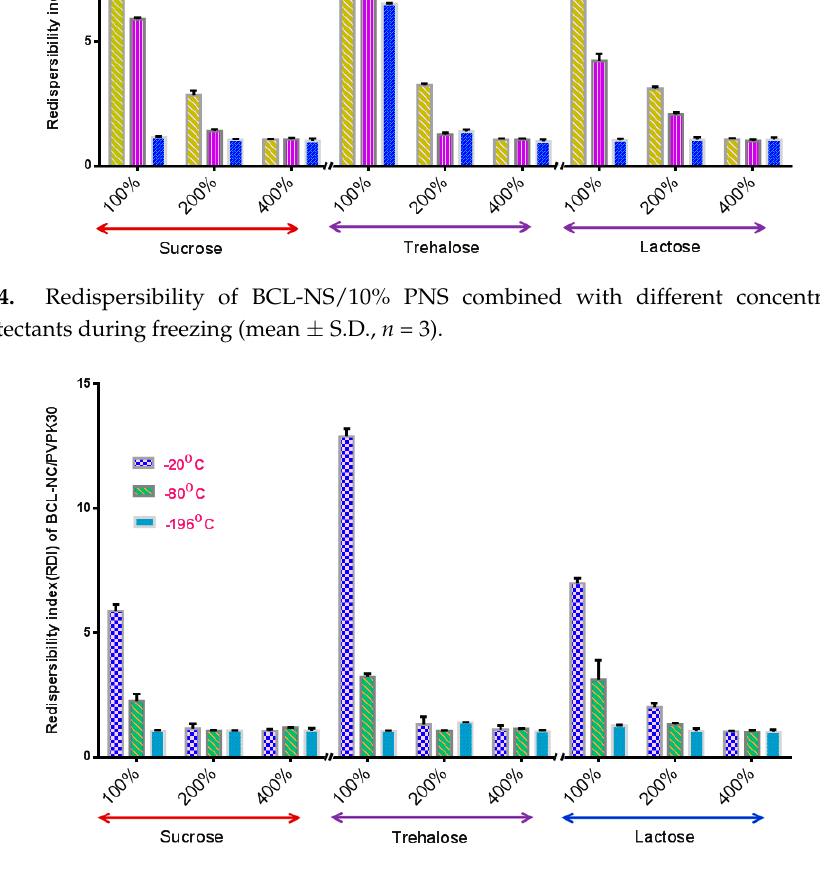
Figure 5. Redispersibility of BCL-NS/10% PNS combined with different concentrations of cryoprotectants during freezing (mean ± S.D., n = 3).